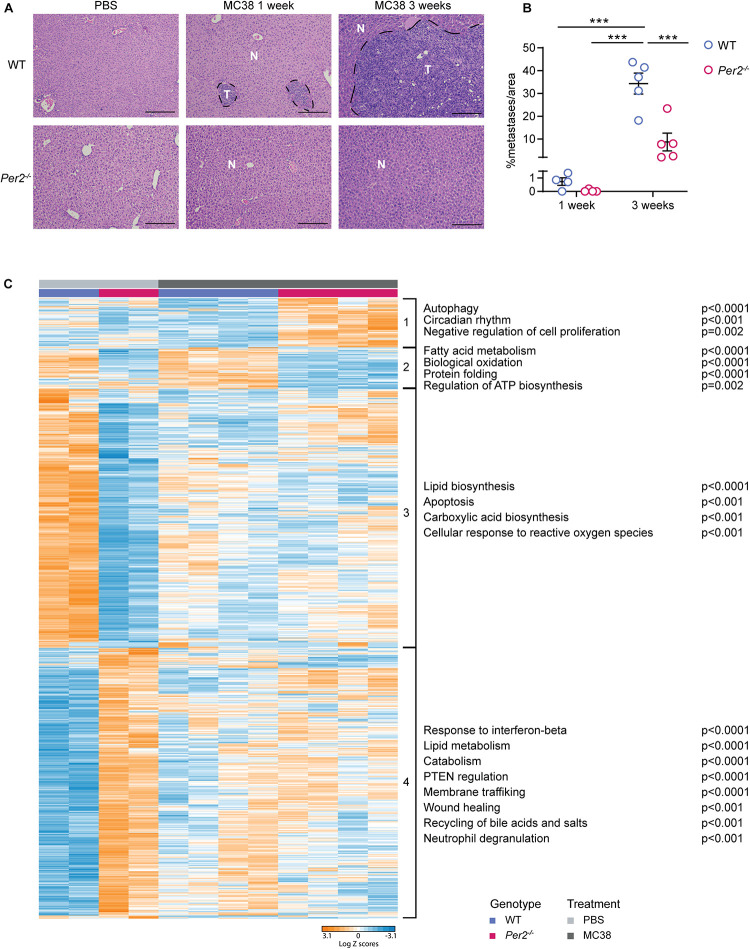
Stromal Per2–/– is essential for the formation of the pre-metastatic niche. WT and Per2–/– mice were injected with MC38 cancer cells into the hepatic portal vein and sacrificed 1 or 3 weeks post injection, as indicated. PBS was injected to control mice which were sacrificed 1 week post injection. n = 4–5 mice per genotype. (A) Representative H&E staining of livers from WT and Per2–/– mice post injection of PBS or MC38 cancer cells. Scale bar – 200 μm, inset – 67 μm; T-tumor, N-normal tissue. (B) The area covered by metastases in MC38-injected livers was calculated by QuPath based on H&E images. P-value was calculated using two way ANOVA. Error bars represent SEM, ***p < 0.0005. (C) RNA-sequencing was performed on livers of WT and Per2–/– mice injected with MC38 (n = 4 per genotype) and PBS (n = 2 per genotype). Heatmap showing hierarchical clustering of 1222 differentially expressed genes between all four conditions. Pathway analysis was performed using Metascape. Significant pathways are shown; p < 0.05, FDR < 0.05 (for details see Supplementary Table 2).